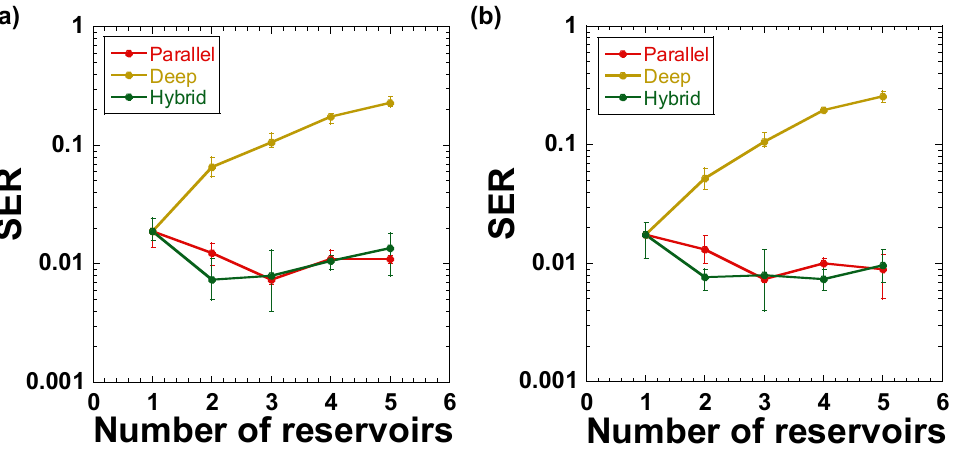
Figure 8: Symbol error rate (SER) of the nonlinear channel equalization task as the number of reservoirs k is changed for parallel (red), deep (brown), and hybrid (green) configurations. (a) The number of nodes for each reservoir is fixed at N = 160. (b) The total number of nodes is = fixed at N total